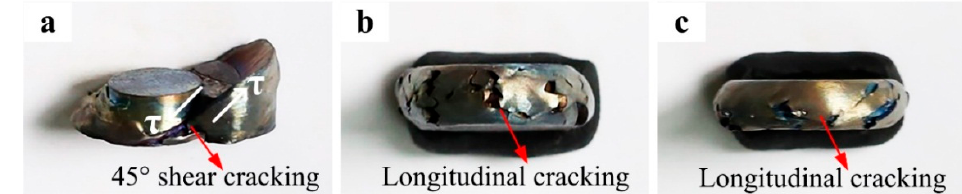
Figure 6. The fracture and cracking modes of the compressed IM Ti-5553 alloy specimens at various conditions: ( a ) 700 °C/10 s − 1 ; ( b ) 700 °C/1 s − 1 ; and ( c ) 700 °C/0.01 s − 1 .